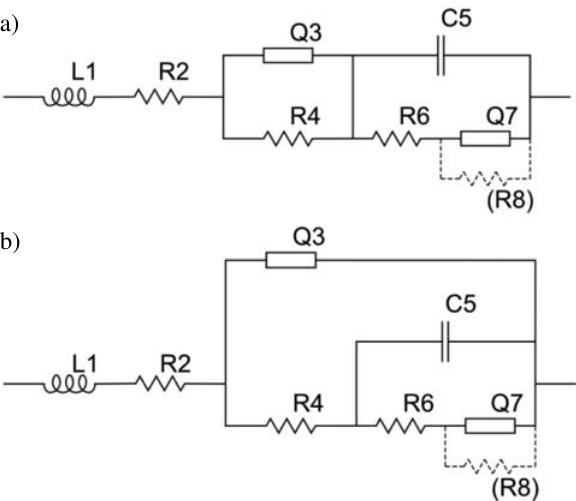
Figure 4. The equivalent circuit used for fitting the impedance spectra. a) circuit #1, b) circuit